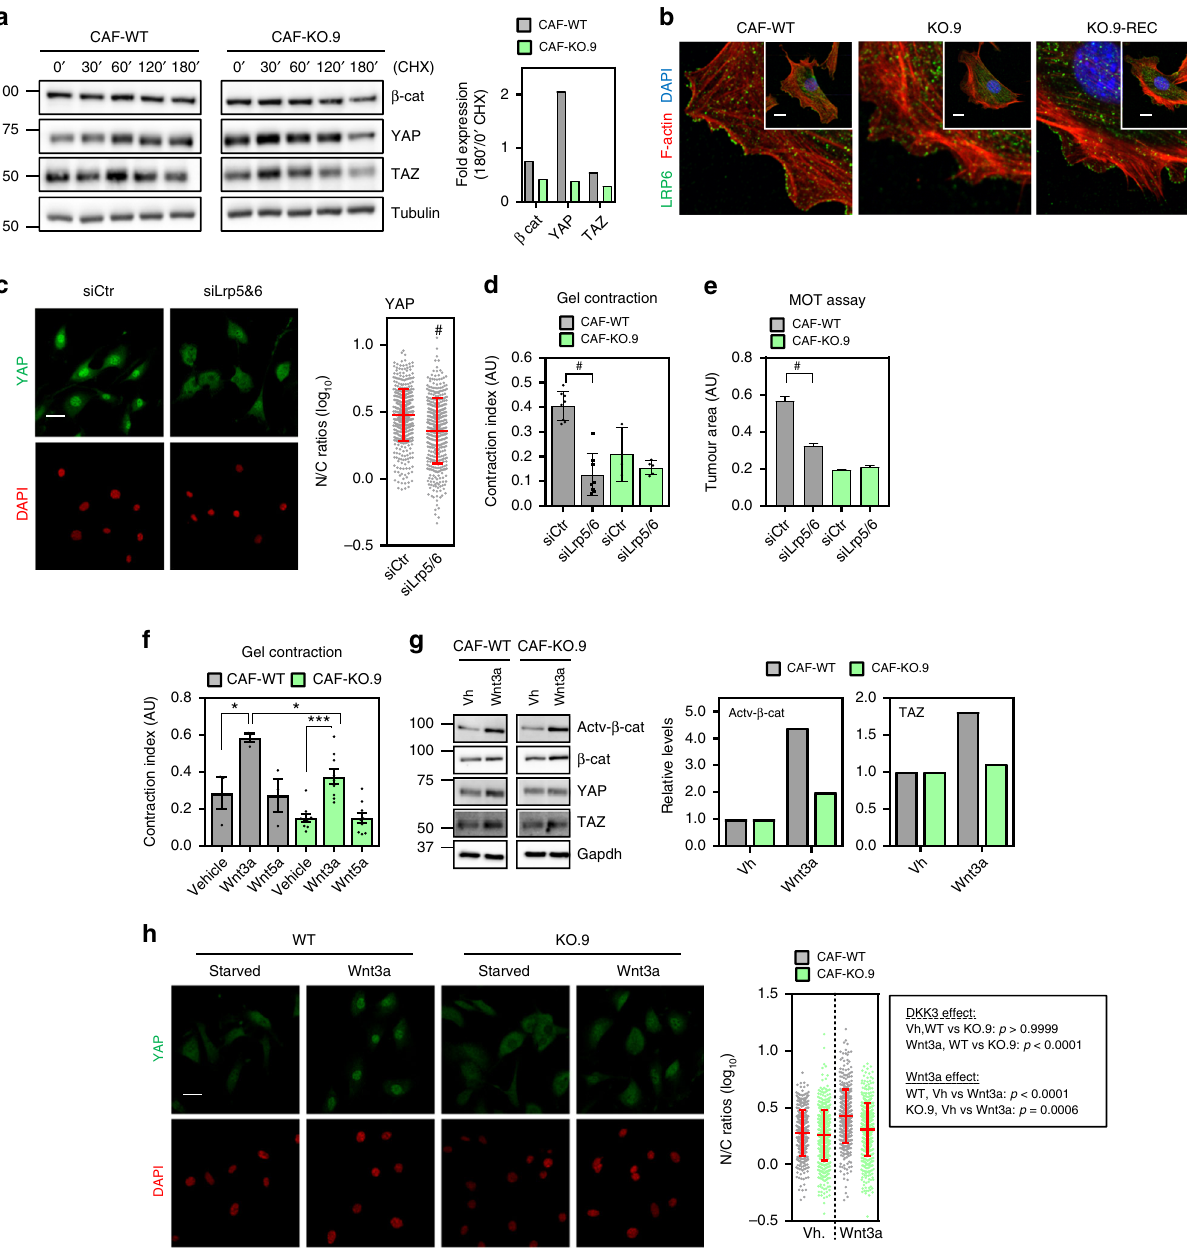
Fig. 7 DKK3 potentiates canonical Wnt signalling and affects YAP/ β -catenin degradation. a Western blots show β -catenin, TAZ, YAP and tubulin expression in murine WT and KO.9 CAFs after treatment with 100 μ g mL − 1 cycloheximide (CHX) for the indicated times (in min). Graph represents quanti fi cation of the indicated blots (normalised to tubulin) at 180 min relative to the amount at 0 min. b Low and high magni fi cation images of LRP6 (green), F-actin (red) and DAPI (blue) staining of murine WT, KO.9 and KO.9-REC CAFs in 1% FBS. Scale bars, 15 μ m. c Images show YAP (green) and DAPI (red) staining of CAF1 after transfection with control (siCtr) and LRP5&6 siRNA (smart-pool). Bar, 50 µ m. Graph shows quanti fi cation of nuclear relative to cytosolic fl uorescent intensity (log 10 ratios) of YAP. Lines represent mean ± SEM. d Graph shows gel contraction index of murine WT and KO.9 CAFs after transfection with control (siCtr) or Lrp&6 (siLrp5/6) siRNAs. Bars represent mean ± SEM ( n = 3 or more). e Graph shows the area of colonies formed by TS1 MOT co-culture with WT and KO.9 CAFs after transfection with control (siCtr) or Lrp5&6 (siLrp5/6) siRNAs. Bars represent mean ± SEM ( n = 584 or more colonies from at least 3 independent experiments). f Graph shows gel contraction of WT and KO CAFs cultured in 5% FBS and stimulated with vehicle or 200 ng mL − 1 of Wnt3a or Wnt5a. Bars represent mean ± SEM ( n = 3). KO data are merged results of KO.2, KO.7 and KO.9 on triplicate ( n = 9). g Western blot showing levels of non-phospho (active) β -catenin (Ser33/37/Thr41), β -catenin, YAP, TAZ and Gapdh in WT and KO.9 CAFs after stimulation with vehicle ( − ) or 200 ng mL − 1 of Wnt3a for 3 h. Graph represents quanti fi cation of blots indicating the fold levels normalised to Gapdh. h Images show YAP (green) and DAPI (red) staining of murine WT and KO.9 CAFs after 16 h starvation followed by stimulation with vehicle (Starvation) or 200 ng mL − 1 of Wnt3a for 3 h. Bar, 50 µ m. Graph shows quanti fi cation of nuclear relative to cytosolic fl uorescent intensity (log 10 ratios) of YAP. Lines represent mean ± SEM. Individual p values for different comparisons are shown. For all graphs, * P < 0.05; ** P < 0.01; *** P < 0.001; # P < 0.0001; n.s., non-signi fi